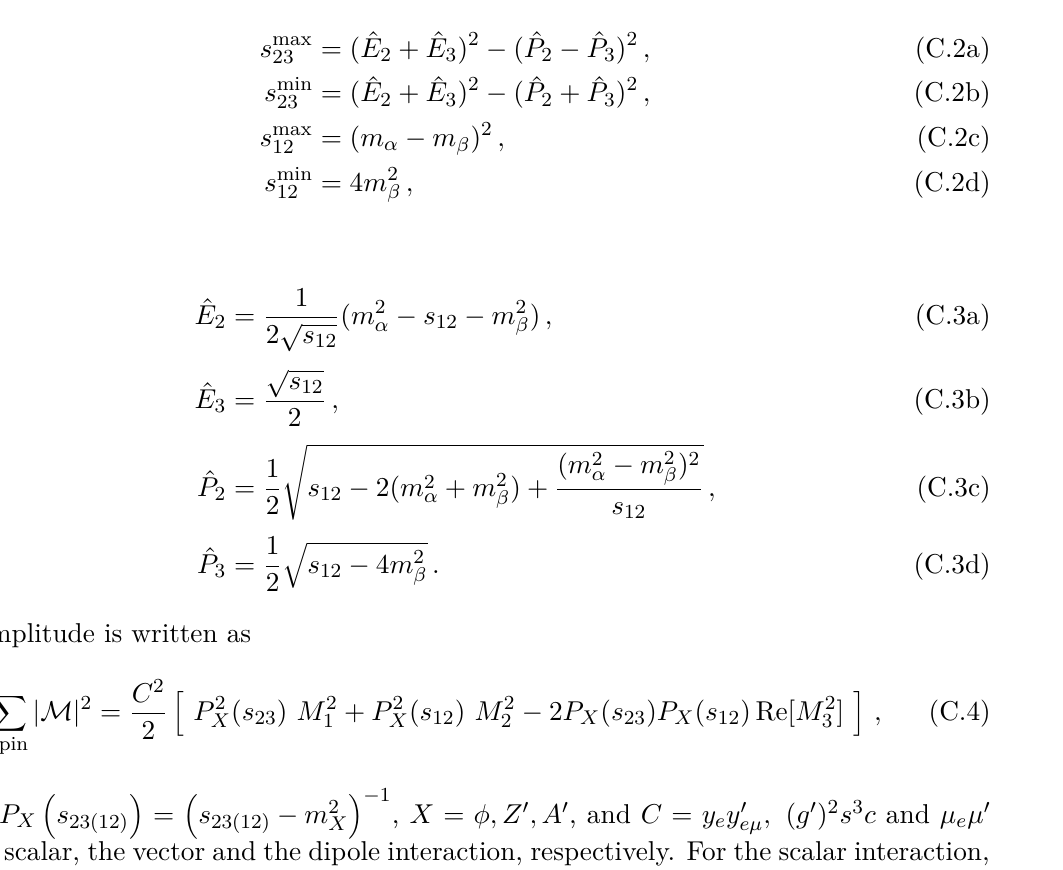
Figure 11 . Feynman diagrams of the process ‘ − lepton and X = φ, Z 0 , A 0